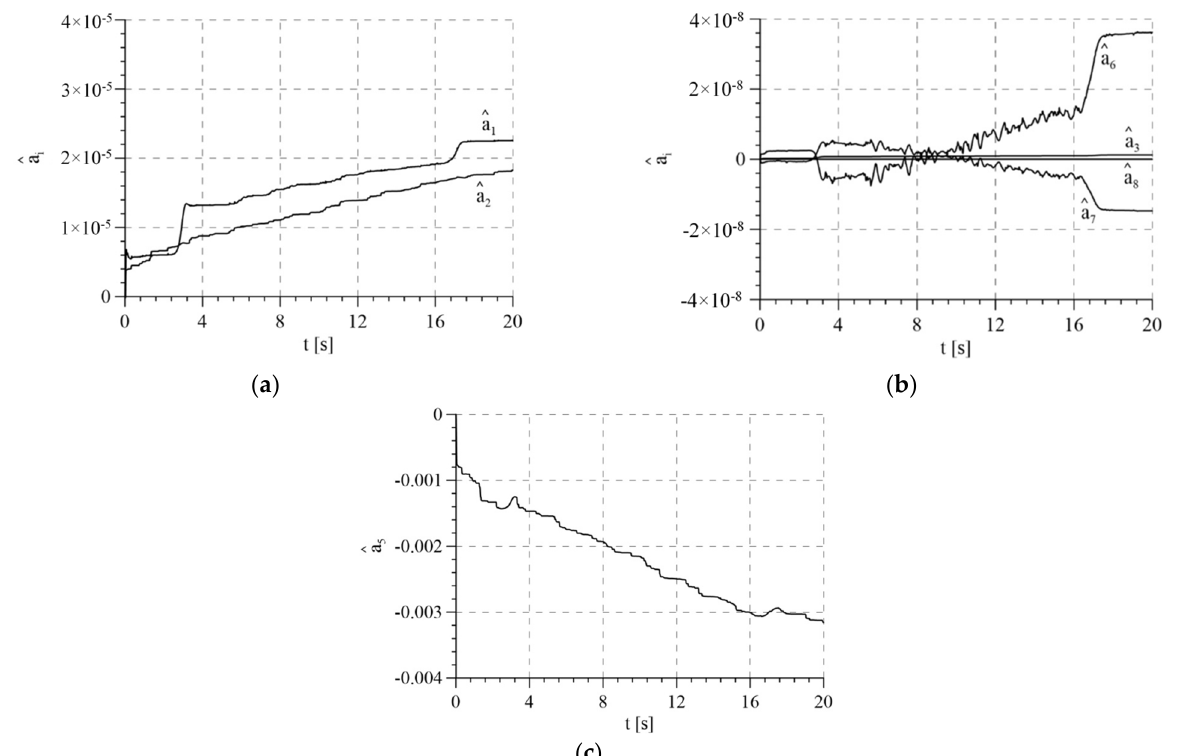
Figure 15. Tracking errors: ( a ) tracking error of the passive part of the system—force error; ( b ) tracking error or the active part of the system—rotation angle error.